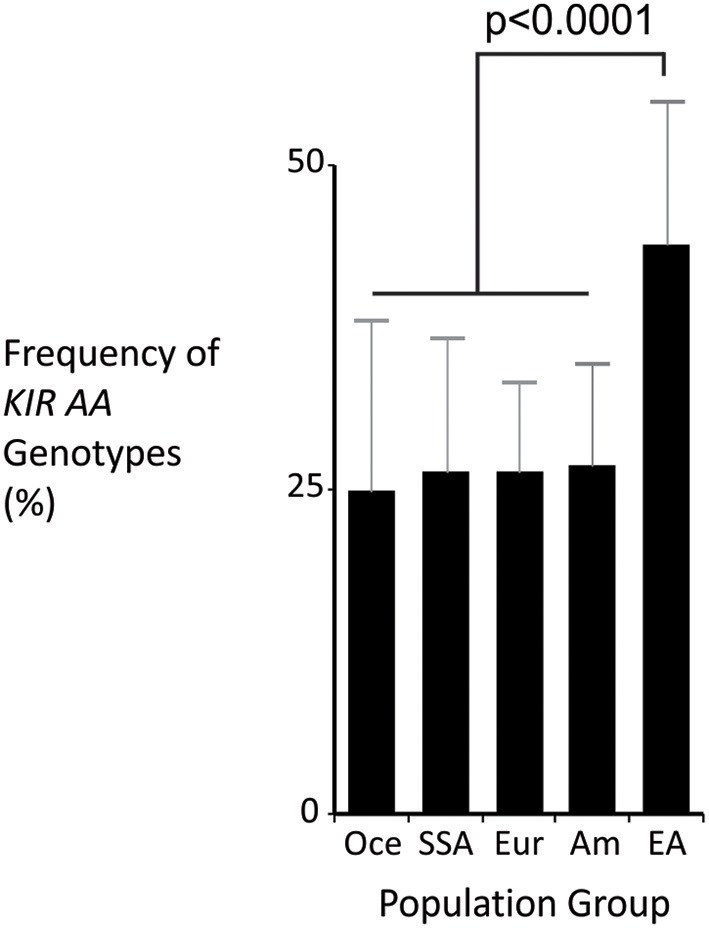
The KIR AA genotype is most frequent in East Asia. Mean frequencies of the KIR AA genotype from multiple populations representing major world groups: Oce—Oceanian (13 populations), SSA –sub-Saharan African (13 populations), Eur—European (60 populations), Am—Amerindian (24 populations), EA—East Asian (31 populations). Data were obtained from allelefrequencies.net (21). ANOVA test for between group differences p = 2.1 × 10−16. The p-value shown is from t-test of comparison of means: East Asian is significantly different to every other group, with p < 0.001 for each comparison. Vertical bars are S.D.